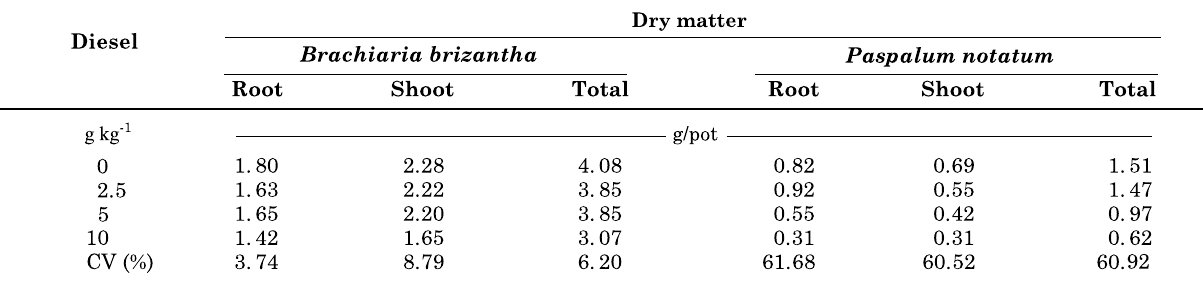
Table 4. Root, shoot and total biomass per plant (average values from triplicates) of Brachiaria brizantha and P. notatum grown on control and diesel-treated soil (0, 2.5, 5 and 10 g kg -1 ) after 10 weeks of